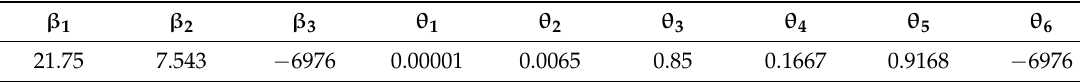
Table 1, are representative of one battery type. Table 1. Values of the parameters in the model.